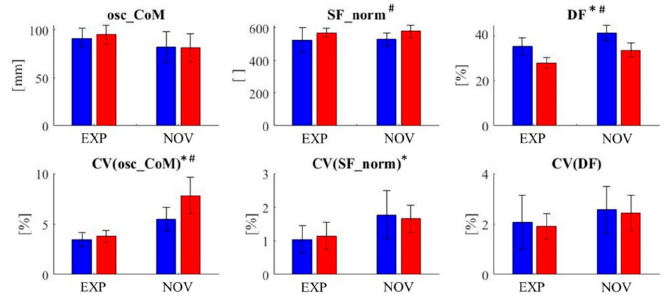
Figure 1. Mean value ( top row ) and coefficient of variation (CV) ( bottom row ) for the three param- eters vertical oscillation of CoM (osc_CoM), normalized stride frequency (SF_norm), and duty factor (DF). The error bars show the standard deviation of the respective values. The values for the 10 km/h condition are shown in blue, and the values for the 15 km/h condition are shown in red; * significant effect for the factor expertise level, # significant effect for the factor speed.